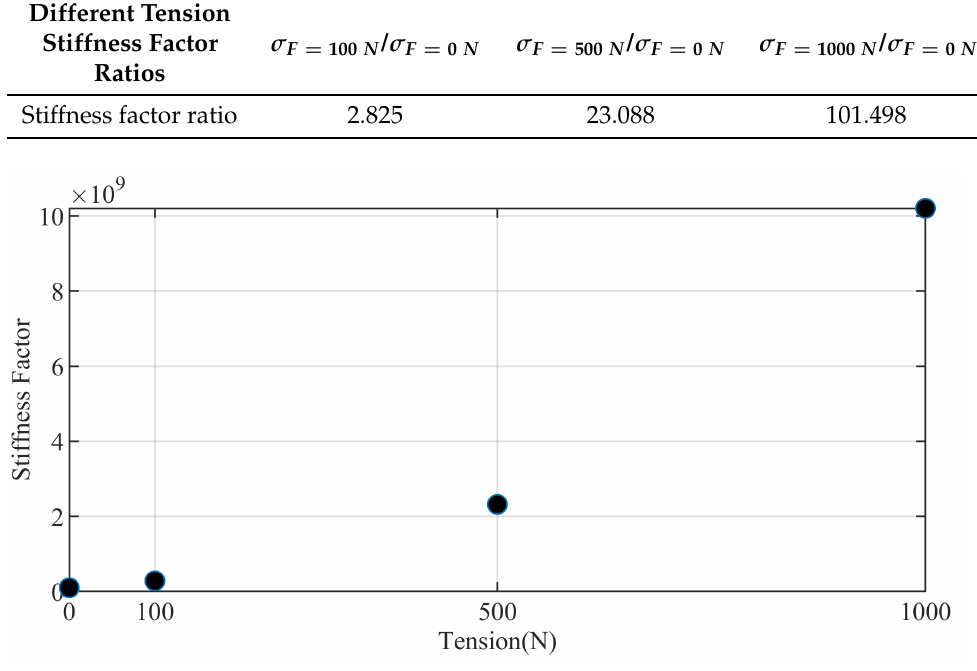
Table 3. Stiffness factor ratio under different tensions.